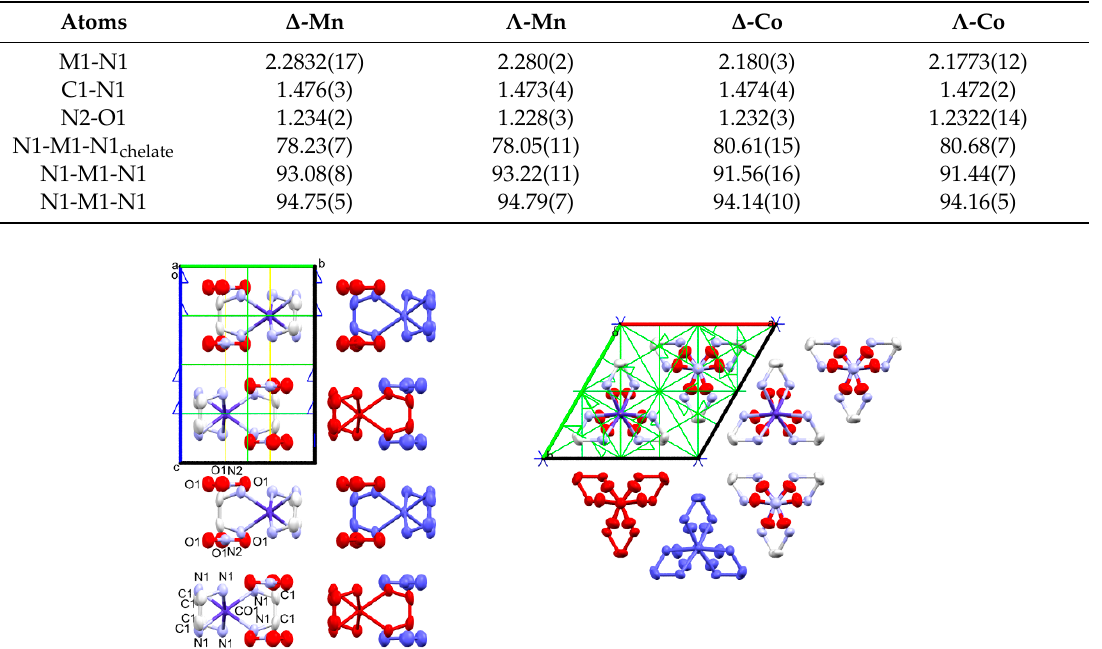
Table 2. Selected bond distances (Å) and angles (°) for [Mn(en) 3 ](NO 3 ) 2 and [Co(en) 3 ](NO 3 ) 2 at 298 K.